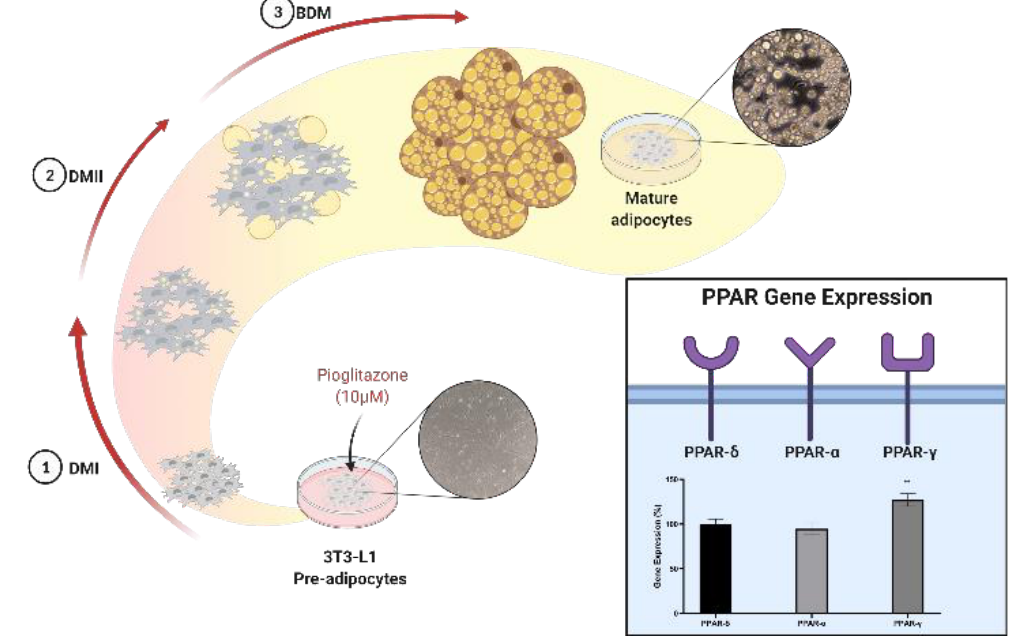
Figure 7. 3T3-L1 differentiation into mature adipocytes through pioglitazone action. This drug mod- ulates significatively (** means p < 0.01) PPAR family activity to enhance the in vitro differentiation of pre-adipocytes at a concentration of 10 µM.